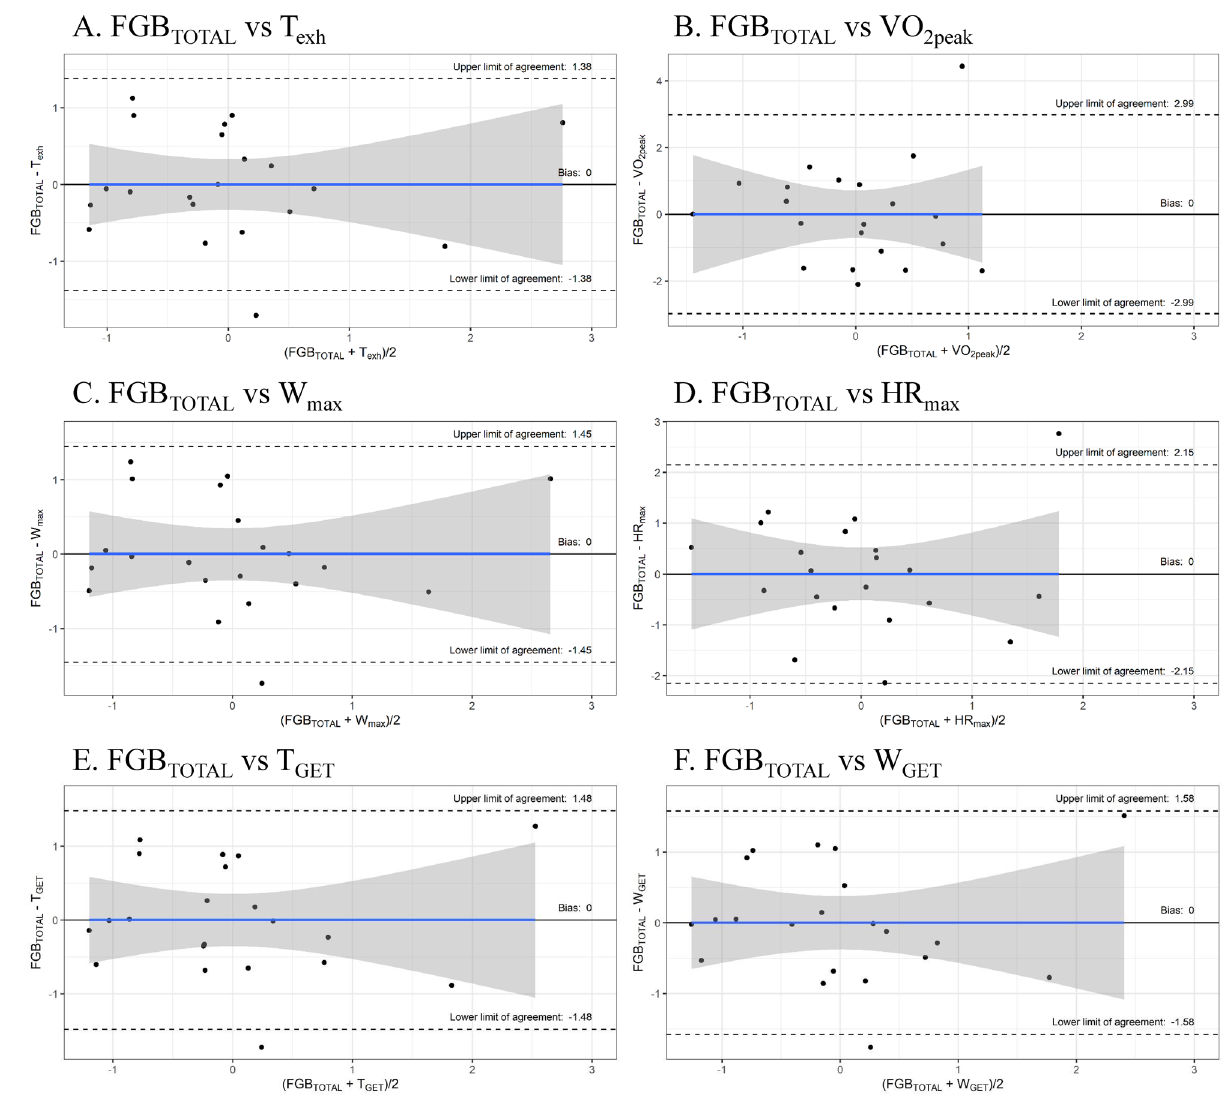
Figure 1. Bland–Altman plots for standardized measures of Fight Gone Bad performance and aerobic capacity. FGB TOTAL , Fight Gone Bad total number of repetitions; HR max , maximal heart rate; T exh , time to exhaustion; T GET , time to gas exchange threshold; W max , maximal workload; W GET , workload at gas exchange threshold; VO 2peak , peak oxygen